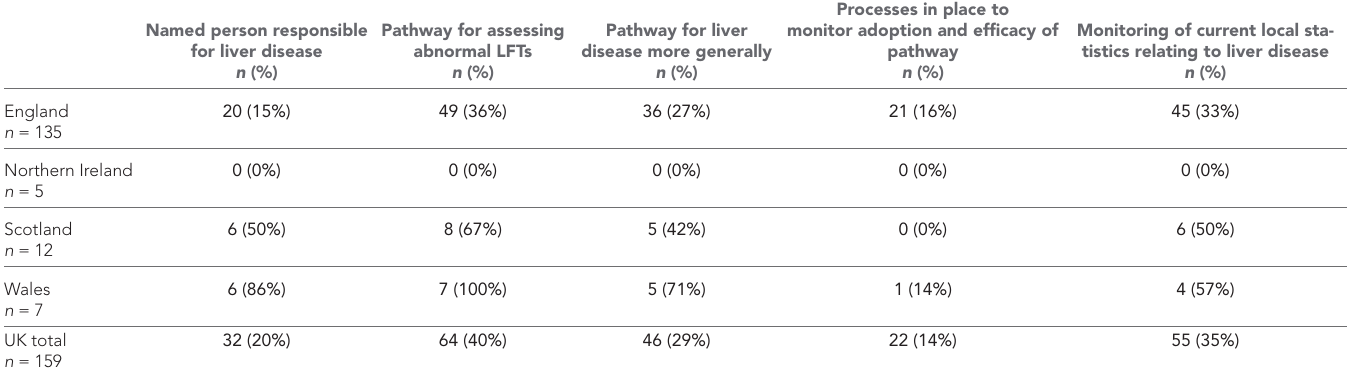
LFTs = liver function tests. n = number of commissioning bodies.